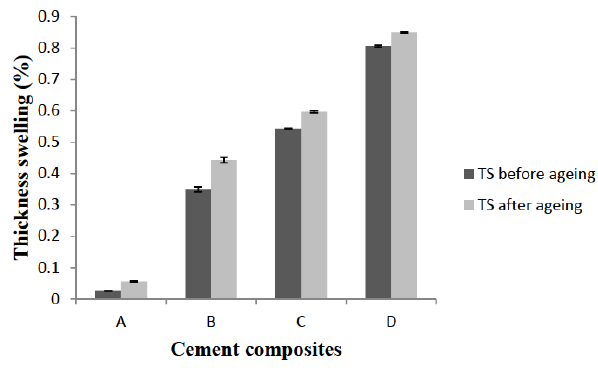
Figure 4: Accelerated ageing effects on water